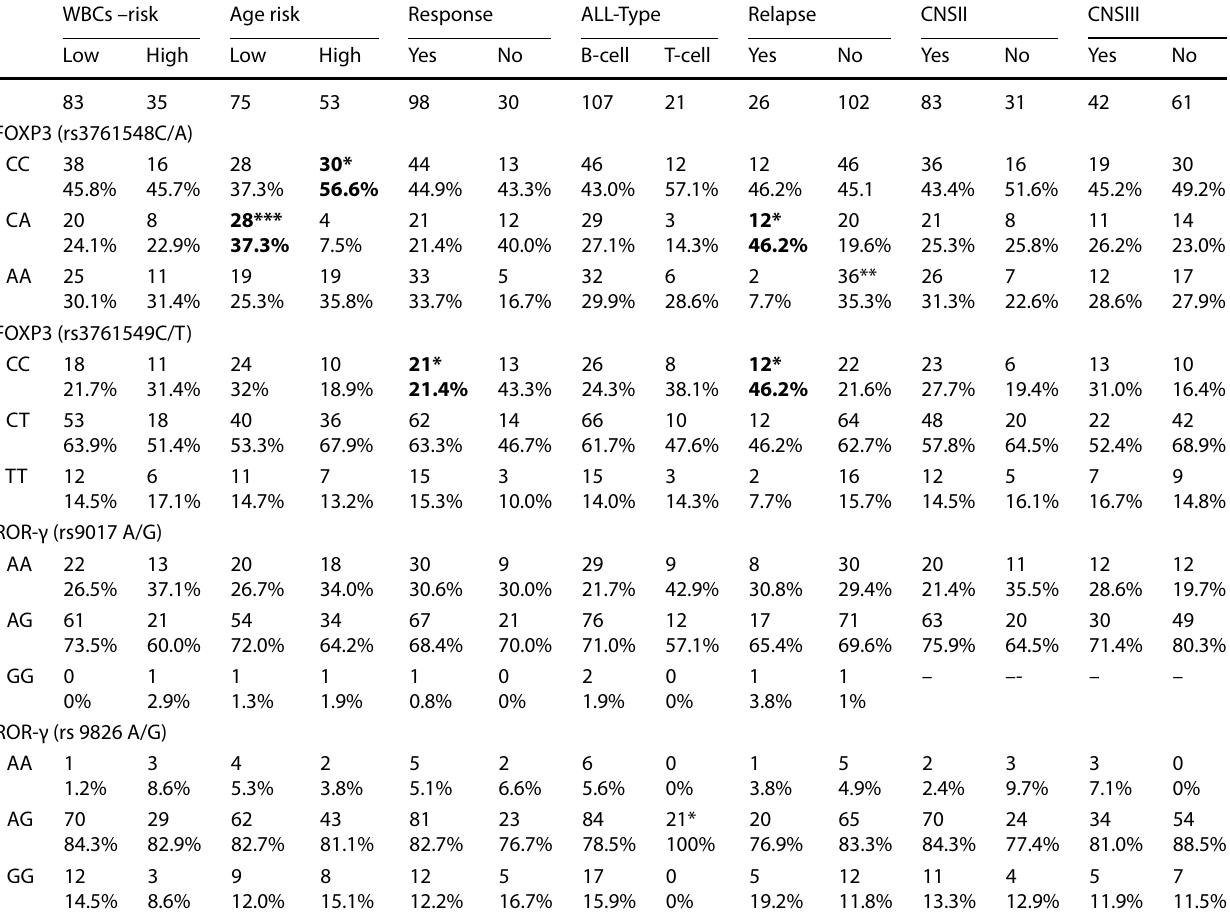
Table 5 Association of the most common clinical findings of the disease and FOXP3&ROR-γ gene polymorphisms inALL